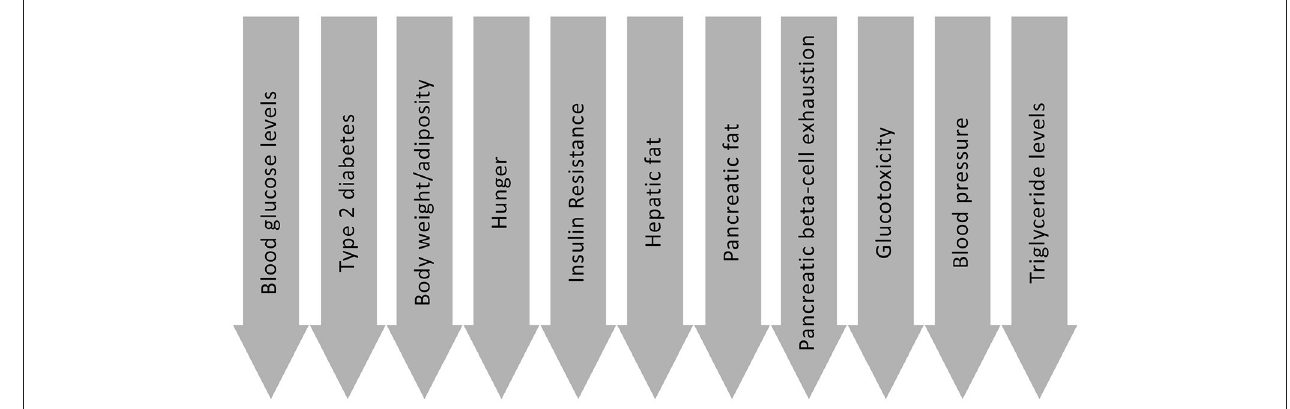
FIGURE 2 | Possible benefits of carbohydrate restriction for people with Type 2